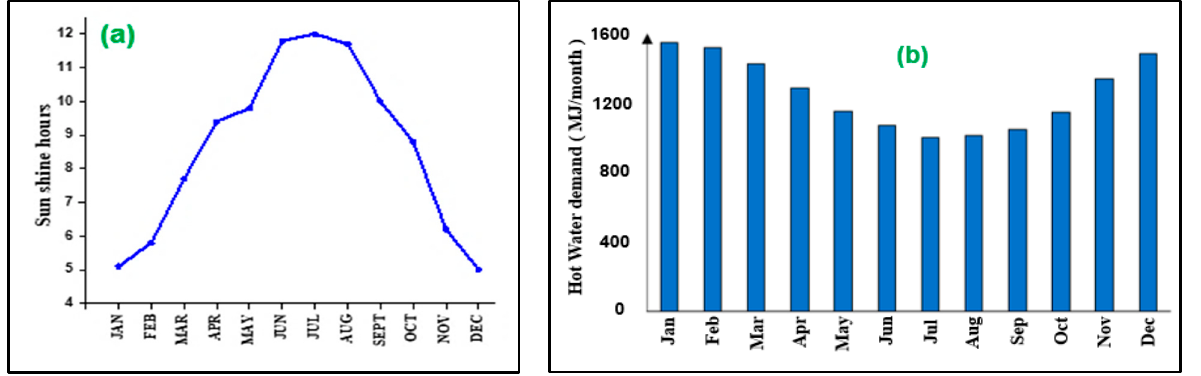
Figure 2. ( a ) The mean sunshine hours with the months of the year in Amman [26]. ( b ) Amman’s hot water costs per month